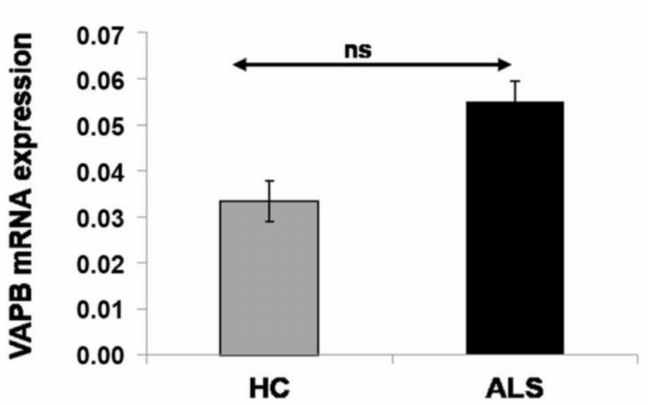
Figure 6. VAPB mRNA expression in PBMCs from HCs ( n = 24) and ALS ( n = 24) patients. mRNA levels were quantified by real-time PCR. mRNA values are normalized by that of GAPDH. Values represent mean ± SD. Each sample was examined in triplicate. VAPB mRNA levels of sALS patients were not significantly di ff erent from those detected in